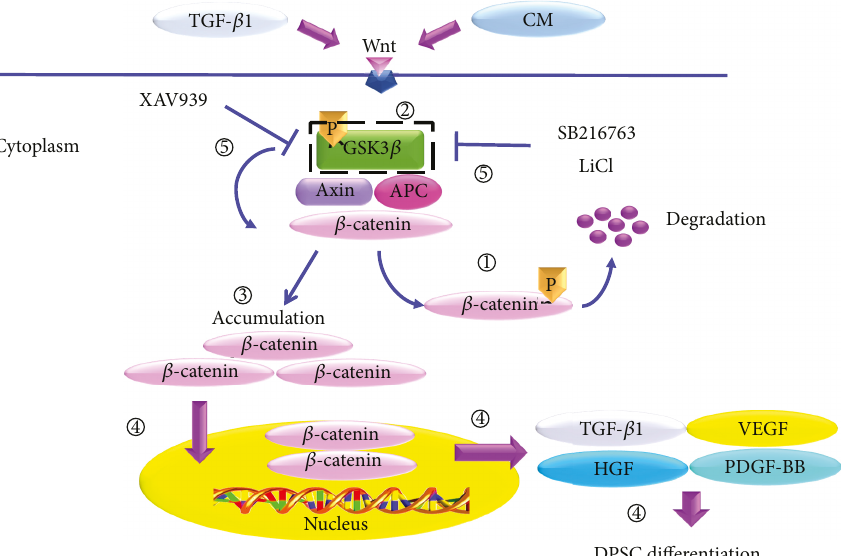
Figure 7: Wnt/GSK3 β / β -catenin activation. 1: in the absence of canonical Wnt signaling, β -catenin is complexed with GSK3 β , APC, and Axin, which facilitate the phosphorylation and subsequent degradation of β -catenin. 2: activation of canonical Wnt signaling by the growth factor, TGF- β 1, and CM from SMC triggers phosphorylation of GSK3 β , thereby disrupting the APC/Axin/GSK3 β / β -catenin complex. 3: β -catenin which dissociates from the APC/Axin/GSK3 β complex escapes from degradation and accumulates in the cytoplasm. 4: the stabilization and accumulation of β -catenin translocates into the nucleus and enhances the expression of growth factors, including TGF- β 1, HGF, VEGF, and PDGF-BB, thus promoting the SMC di ff erentiation from the DPSC clone A32. 5: Wnt/ β -catenin signaling inhibitor, XAV939, and GSK3 inhibitors, SB216763 and LiCl, were used to block the Wnt/GSK3 β / β -catenin